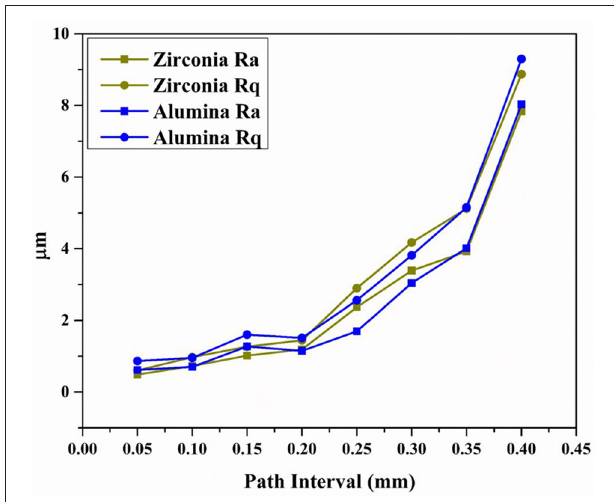
FIGURE 6 | Contact surface profilometry of green machined samples with different path intervals after sintering.